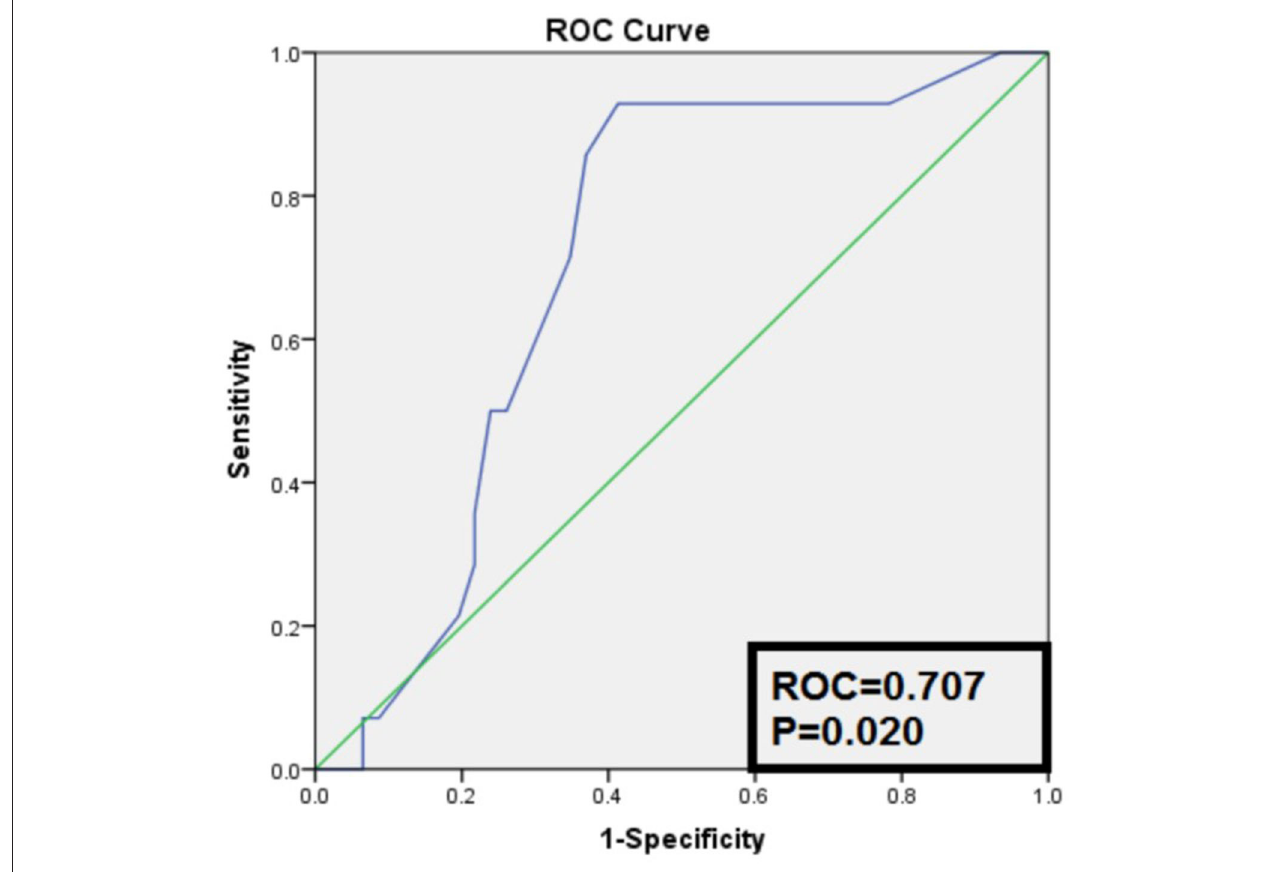
FIGURE 3 | Receiver operation characteristic curve of the duration of hypertension to distinguish remission group from non-remission group.